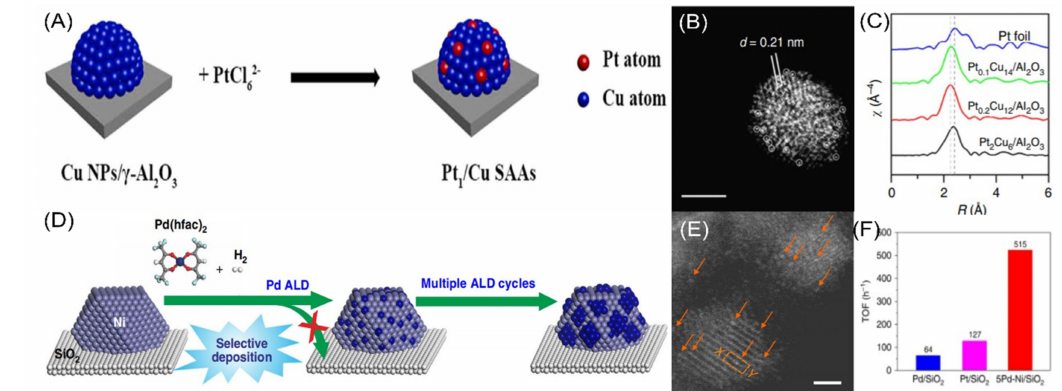
Figure 6. ( A ) Schematic description of GR method to synthesise Pt 1 /Cu SAA NPs, ( B ) HAADF-STEM images of secluded Pt atoms with Cu metal particles using 2nm scale, and ( C ) EXAFS data at room temperature from Pt foil and pre-reduced Pt 0 . 1 Cu 14 /Al 2 O 3 , Pt 0 . 2 Cu 12 /Al 2 O 3 , and Pt 2 Cu 6 /Al 2 O 3 . Adapted with permission from [122], ( D ) schematic flow for the development of Pd 1 Ni SAAs via ALD approach, ( E ) HAADF-STEM image for 5Pd-Ni/SiO 2 using 2 nm scale, and ( F ) the number of turnover frequencies (reaction parameter = 0.5 g catalyst loading under 0.6 MPa H 2 pressure at 80 ◦ C). Adapted with permission from